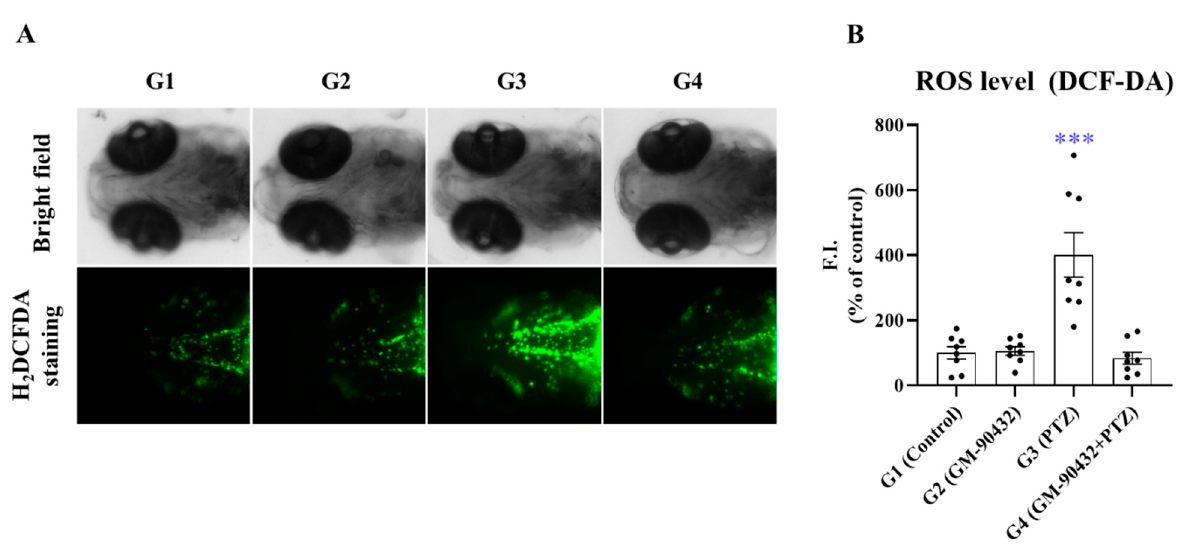
Figure 5. Protective effect of GM-90432 in PTZ-induced ROS generation. ( A ) The intracellular ROS were stained with DCF-DA dye for 20 min. Fluorescence images of ROS generation in zebrafish larvae in the 4 experimental groups. ( B ) The relative fluorescence intensities of ROS levels in individual larvae were quantified. Values represent means ± SEM of 10 samples. Significance between control and exposure groups is indicated by *** p < 0.001.